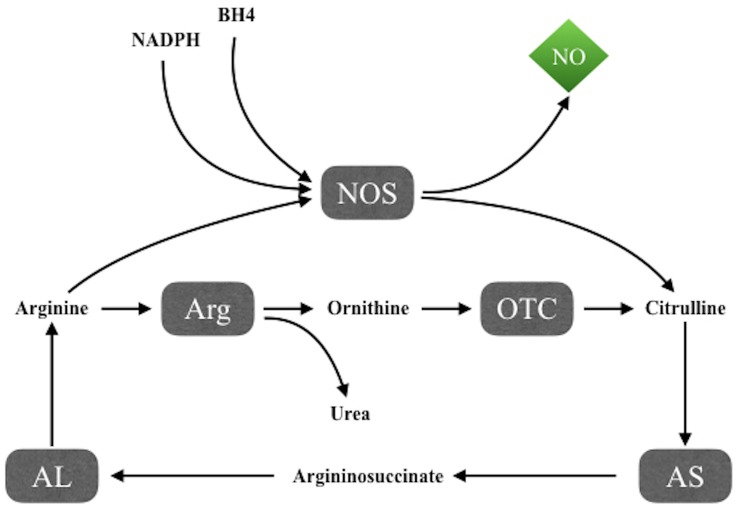
NO synthesis through the NADPH and tetrahydrobiopterin-dependent oxidation of the amino acid L-arginine to L-citrulline by NO synthases. AL, argininosuccinate lyase; Arg, arginase; AS, argininosuccinate synthetase; BH4, tetrahydrobiopterin; NOS, NO synthases; OTC, ornithine transcarbamylase.